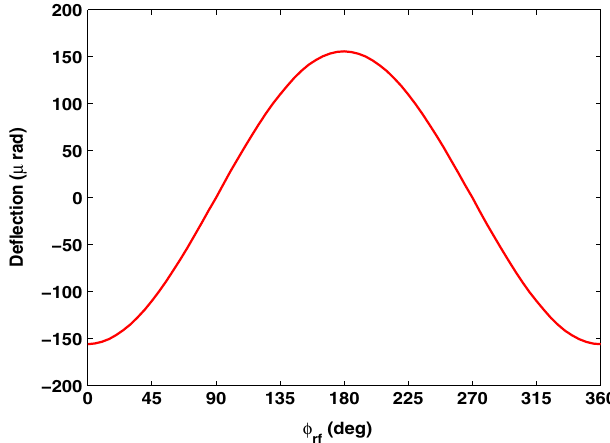
FIG. 6. Vertical deflection versus rf phase at the exit of the cavity shown in Fig. 2.